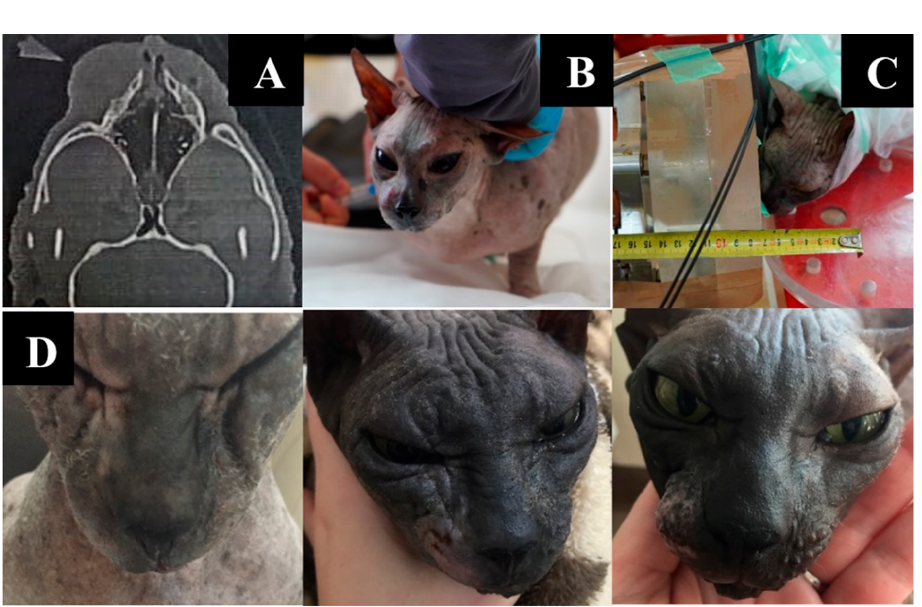
Figure 6. A cat named “Pushok”. ( A )—Tumor on CT scan before irradiation. ( B )—preparation of the animal for irradiation. ( C )—positioning of the animal during the irradiation session. ( D )—dynamics of changes in the size of the formation one, two, and six weeks after irradiation. Pushok developed a tumor relapse 2 months after BNCT. The owner has not responded to subsequent contact requests.